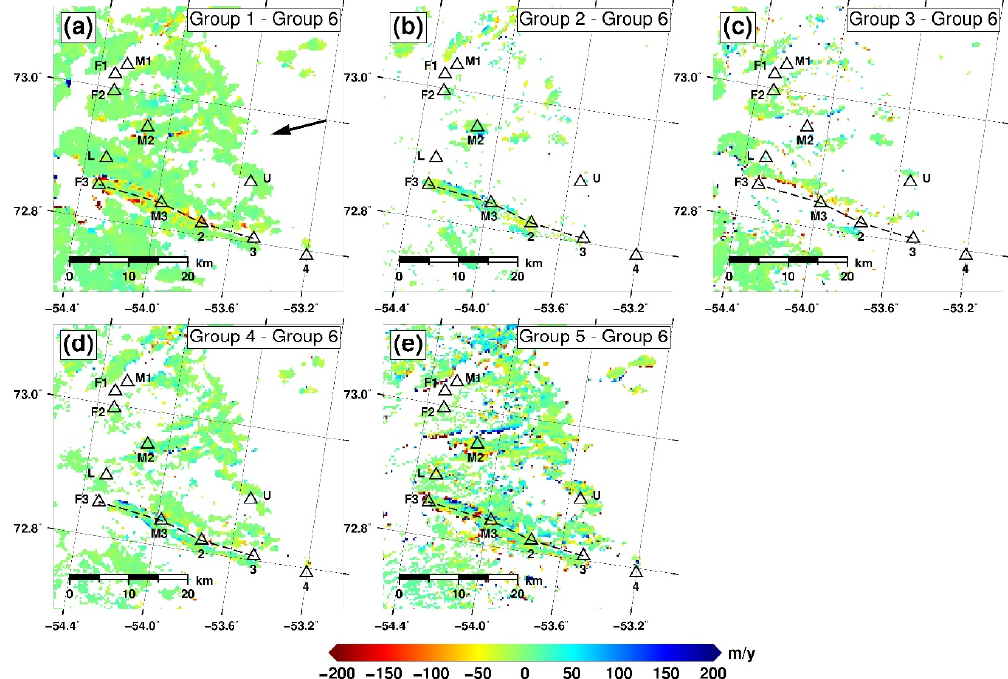
Figure 12. Task 3 LoS velocity differences of groups 1 to 5 ( a – e ) with respect to group 6. The dashed line in the inset represent the trace of the profiles shown in Figure 14.